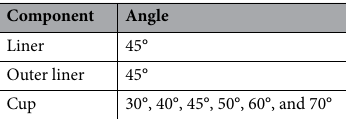
Table 2. Inclination angles of the implant